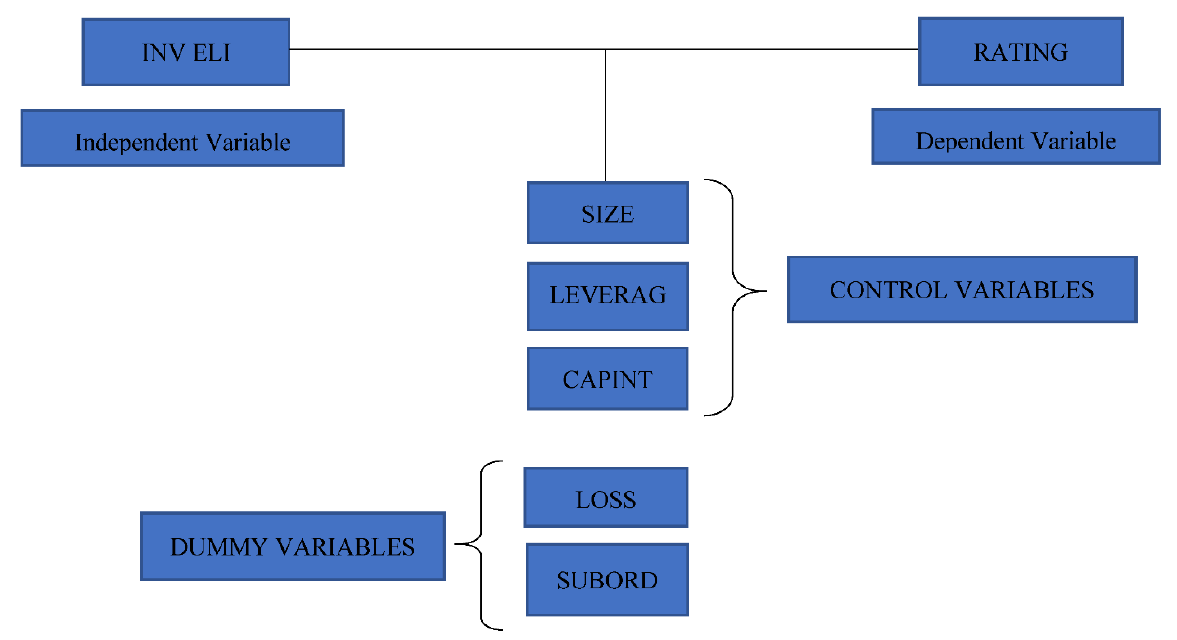
Figure 1. Conceptual framework.